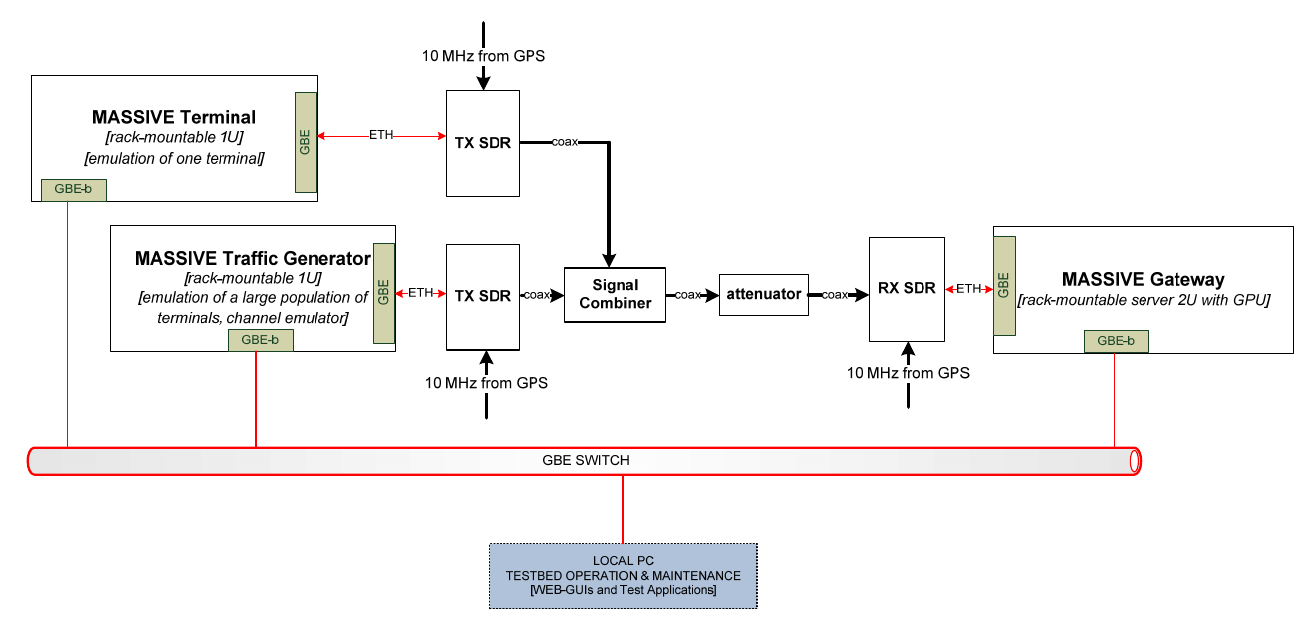
Figure 10. Block diagram of the MASSIVE test-bed.